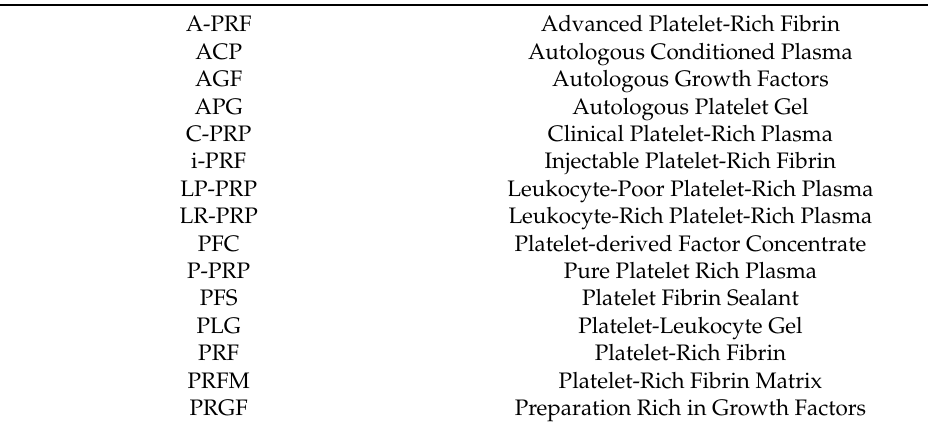
Table 2. PRP product related terminologies and their